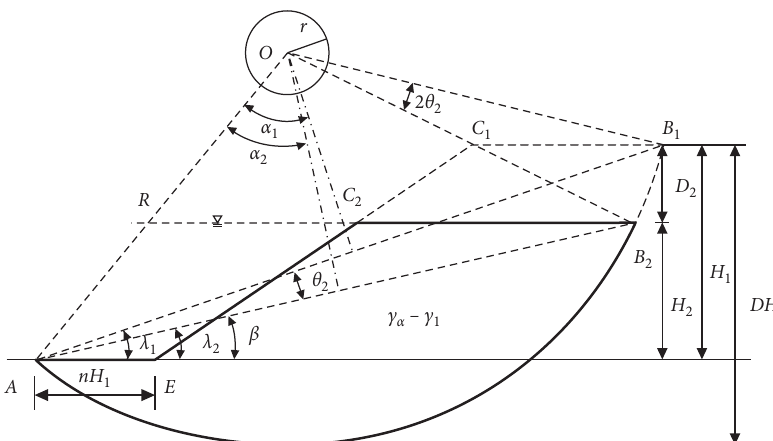
Figure 2: A slope model showing water level and the geometric denomination.